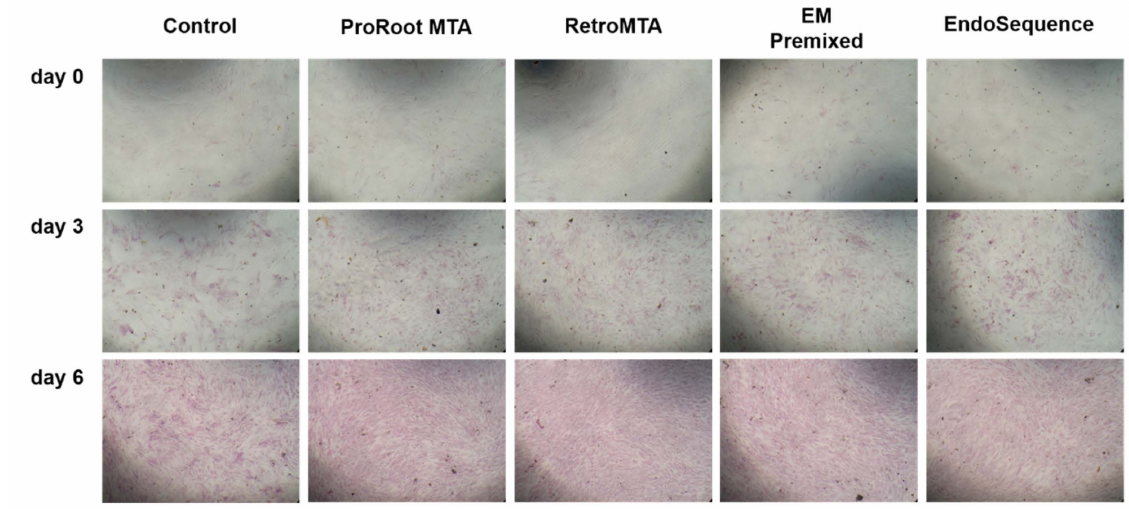
Figure 6. Representative images of alkaline phosphatase (ALP)